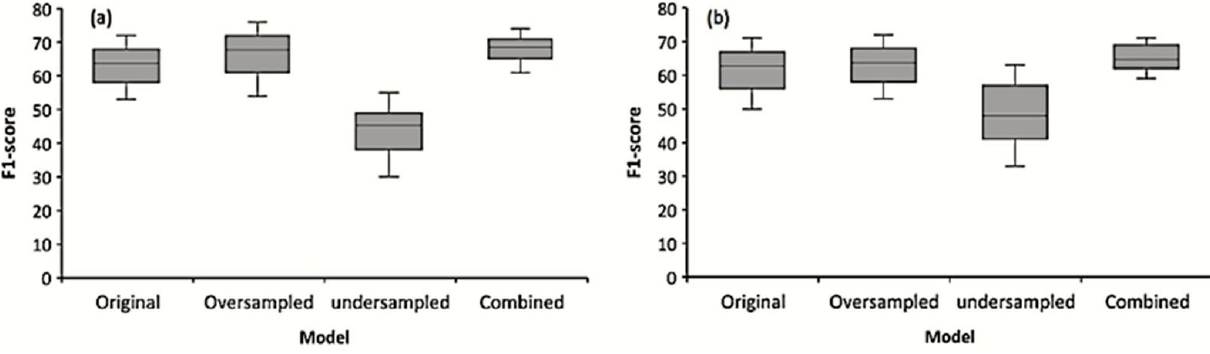
Figure 10. Model ‐ level F1 ‐ score for the datasets: ( a ) RF; ( b ) SVM. Figure 10. Model-level F1-score for the datasets: ( a ) RF; ( b ) SVM.